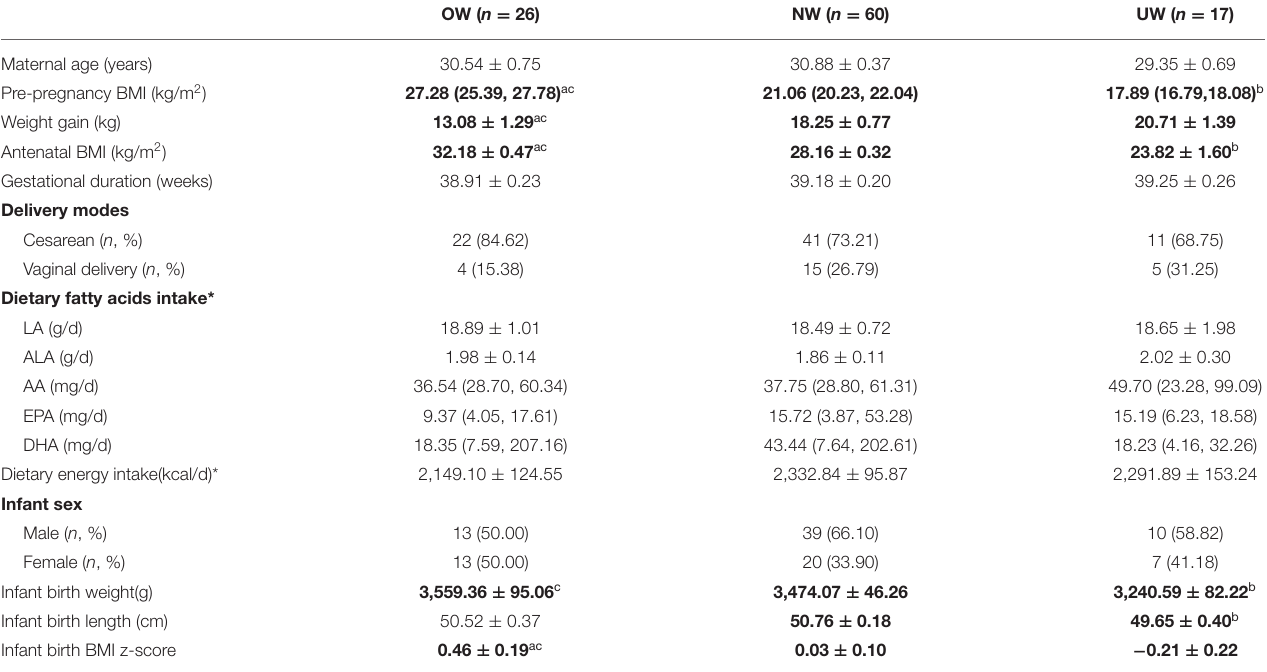
TABLE 1 | Anthropometric and demographic characteristics of mothers and infants according to maternal prepregnancy BMI categories. OW ( n =